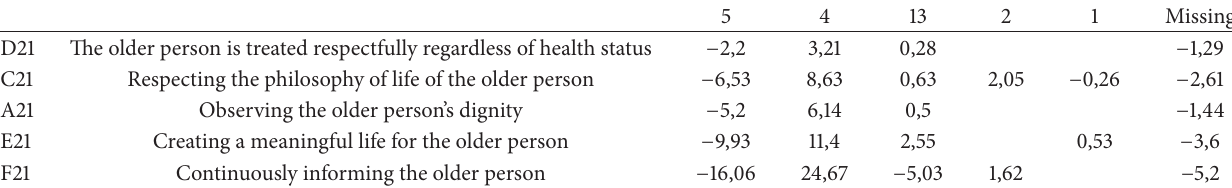
Table 9: Effects on distribution function when B21 fixed to “4” = 100%.